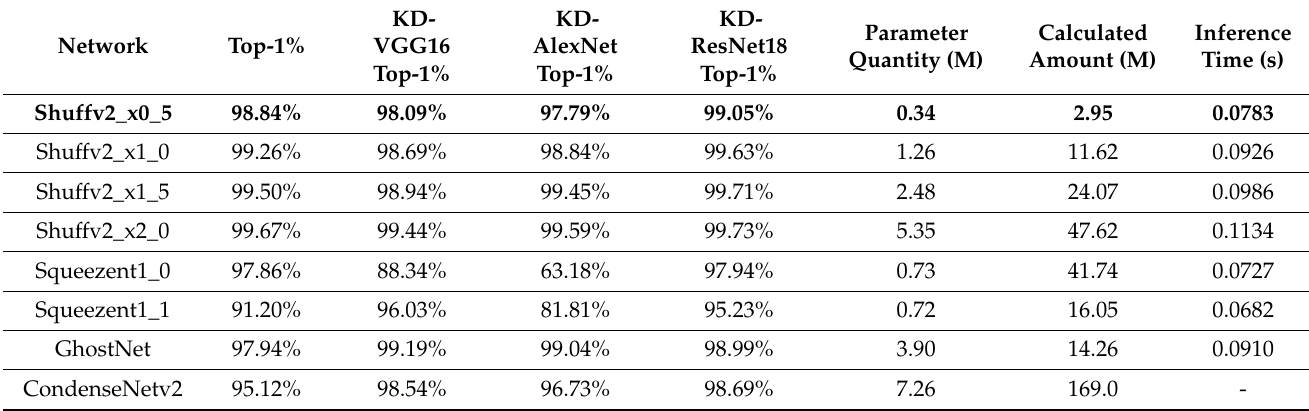
Table 2. Lightweight network; top-1% before and after knowledge distillation, the parameters cardinality, the amount of calculation, and the inference time in NVIDIA Jeston Nano.